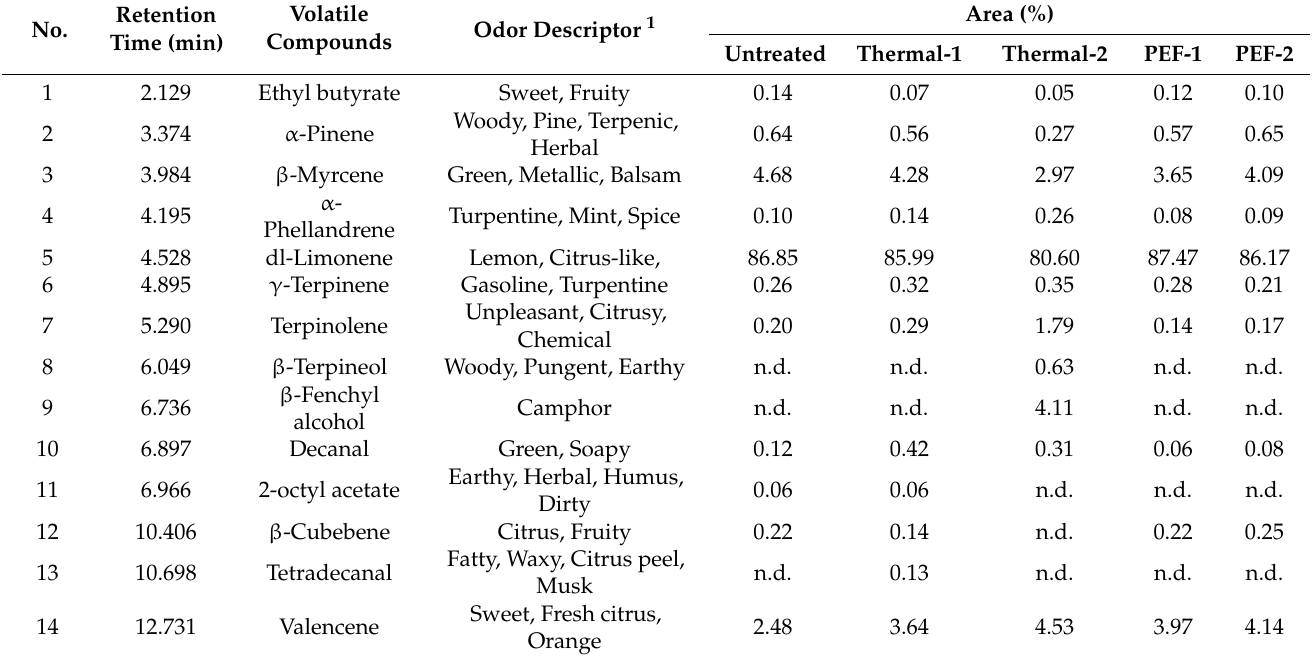
Table 2. Effect of PEF and thermal treatments on the volatile compounds of squeezed orange